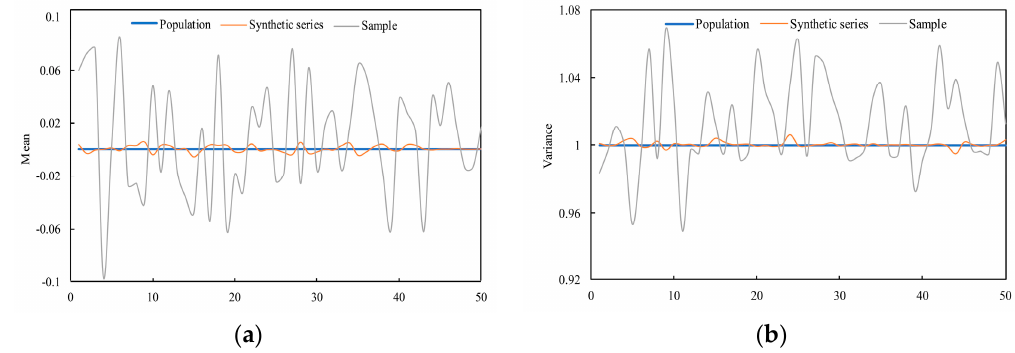
Figure 4. Changes in the mean ( a ) and variance ( b ) of 50 experimental samples, a synthetic series, and the population.